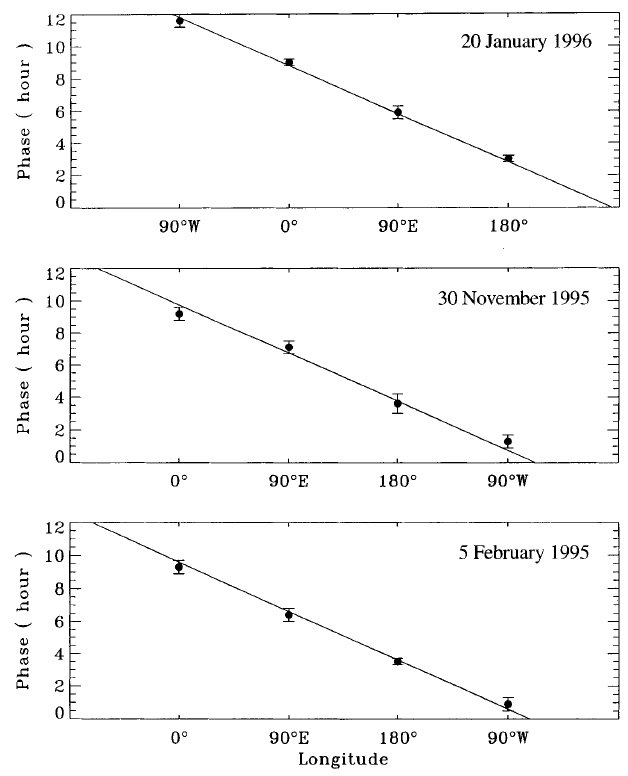
Fig. 4. Phase (UT of maximum) vs. longitude for 3 individual days of measurement, illustrating the zonal wavenumber one character of the oscillation